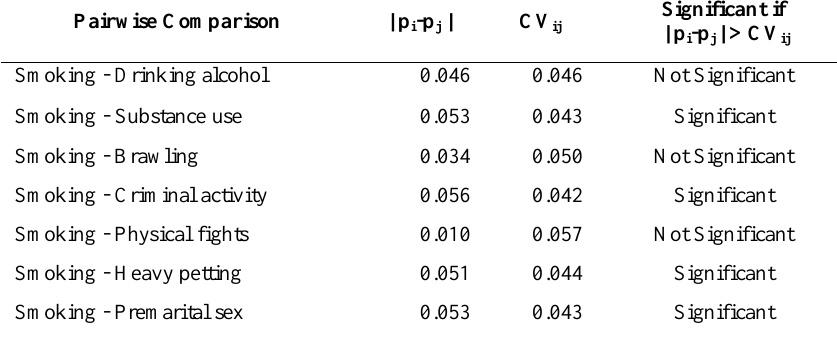
Result of Multiple Comparison using Marascuillo procedures Pairwise